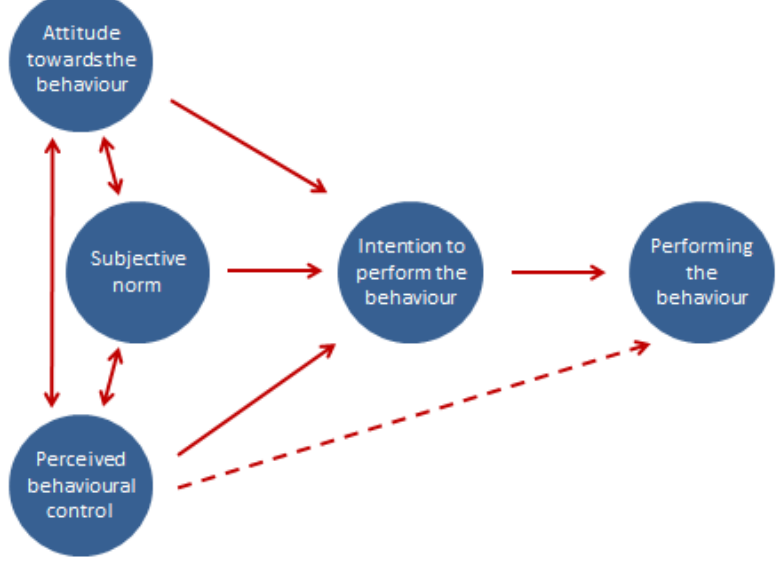
Figure 1. Schematic representation of the Theory of Planned Behaviour. Adapted from [34].